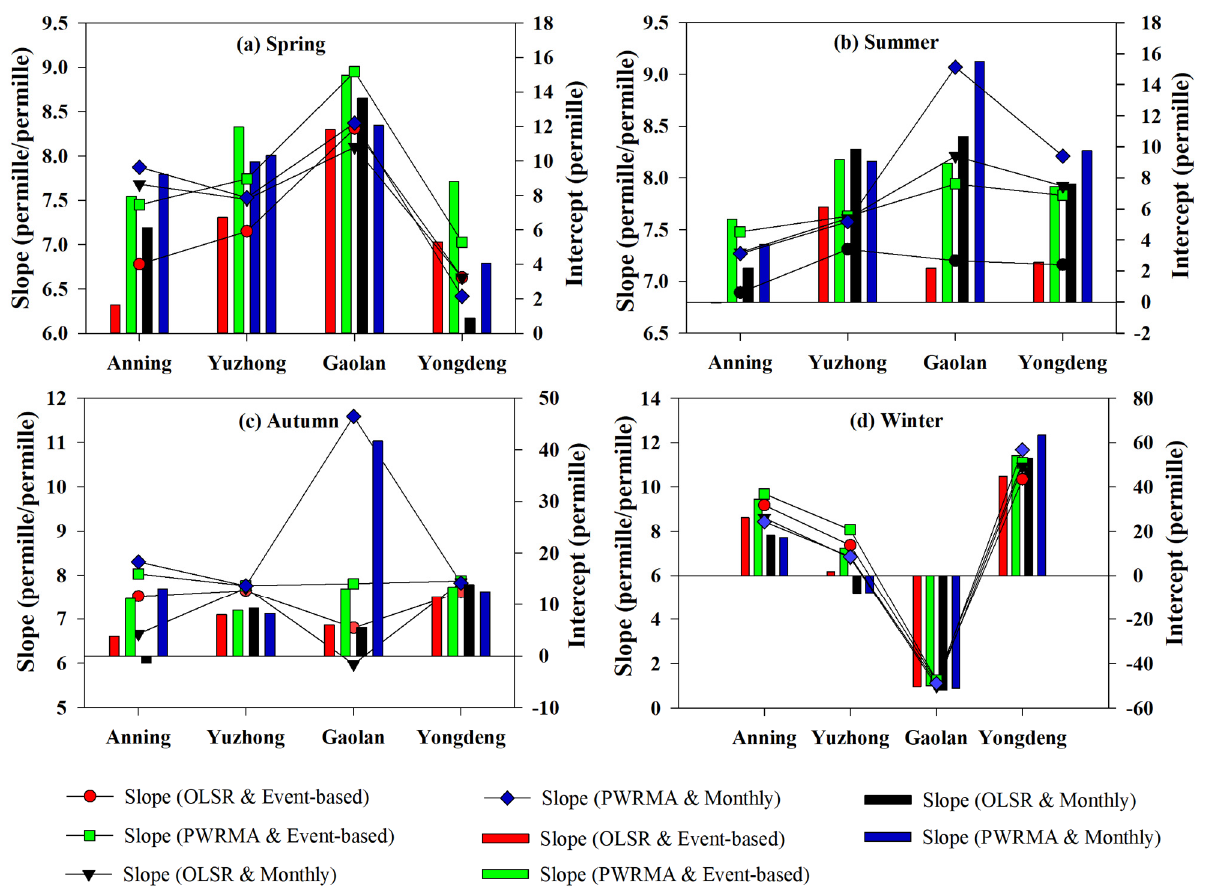
Figure 6. OLSR-based and PWRMA-based LMWL slopes using event-based and monthly data on a seasonal basis for each sampling station in Lanzhou from 2011 to 2014.